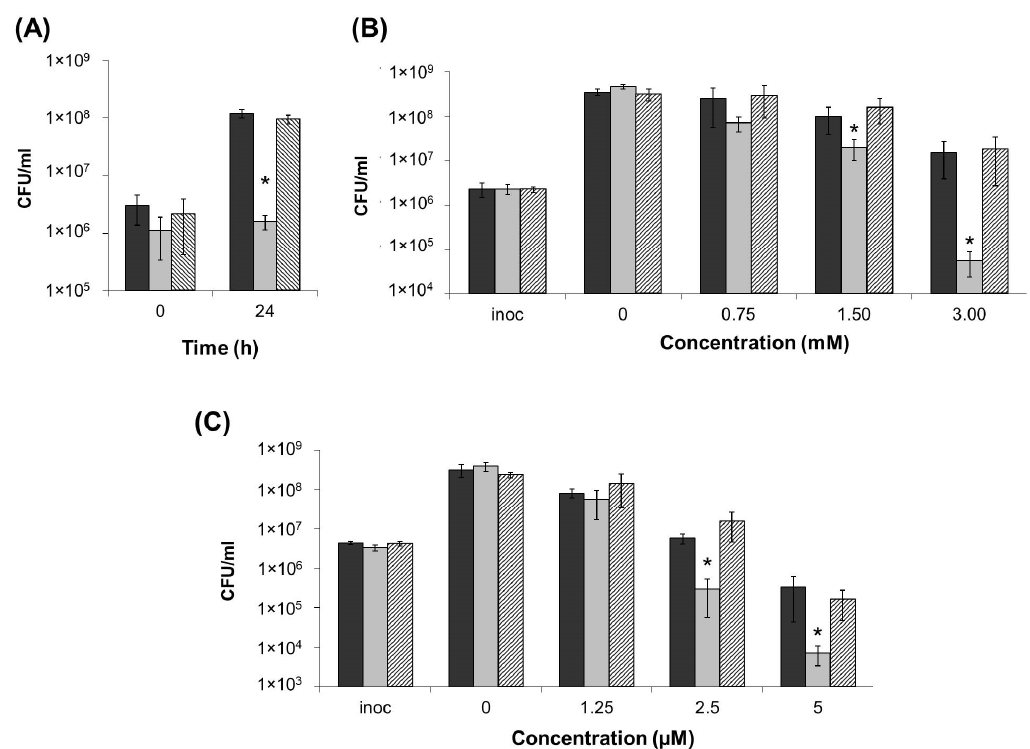
Figure 3. Resistance of the wild type (dark grey), ∆ entA mutant (light grey) and ∆ entA complementation mutant (hashed column) of Pectobacterium atrosepticum SCRI1043 to iron depletion (20 µ M Na-EDTA) ( A ), oxidative stress (H 2 O 2 ) ( B ) and heavy metal (CuSO 4 ) ( C ). Cells were cultured 24 h before plating for CFU titer analysis. The presented values are means ± SD of three biological replicates of one of three representative experiments. Inoc—inoculation titer. Asterisks (*) show the significance of difference (Mann–Whitney two-sided test, p < 0.05).